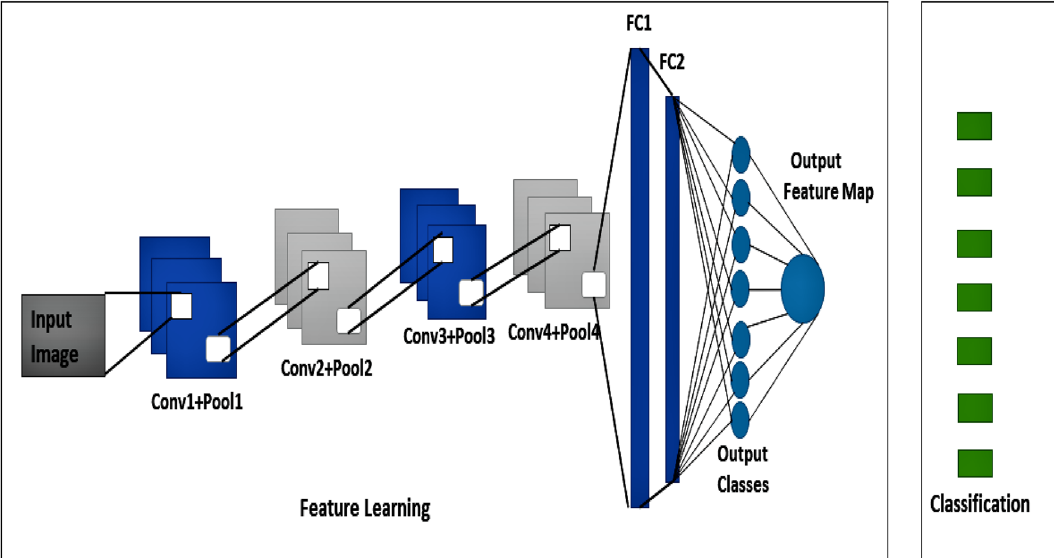
Figure 7. The graphical representation of the proposed CNN model for facial expression